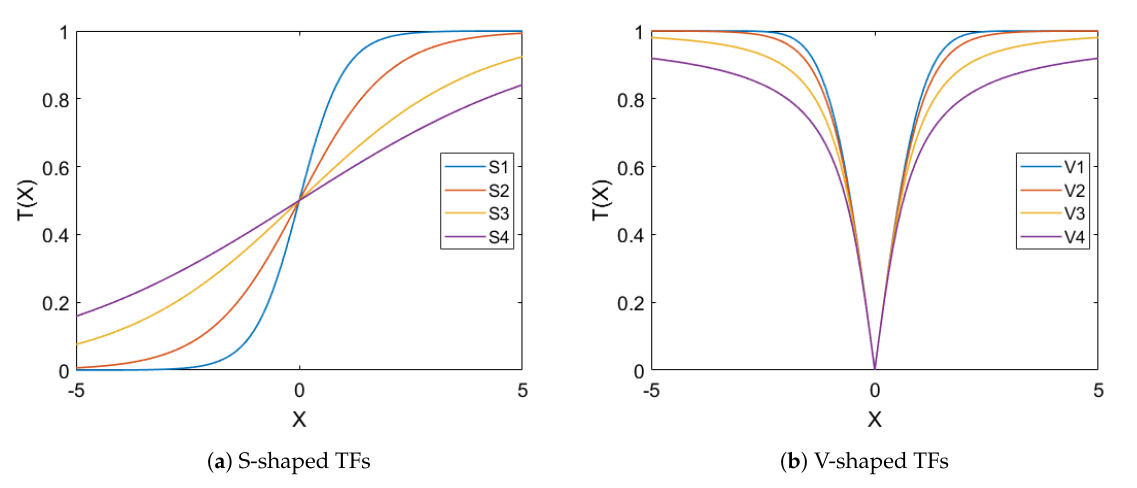
Figure 10. Transfer functions families ( a ) S-shaped and ( b ) V-shaped. Table 1. S-shaped and V-shaped transfer